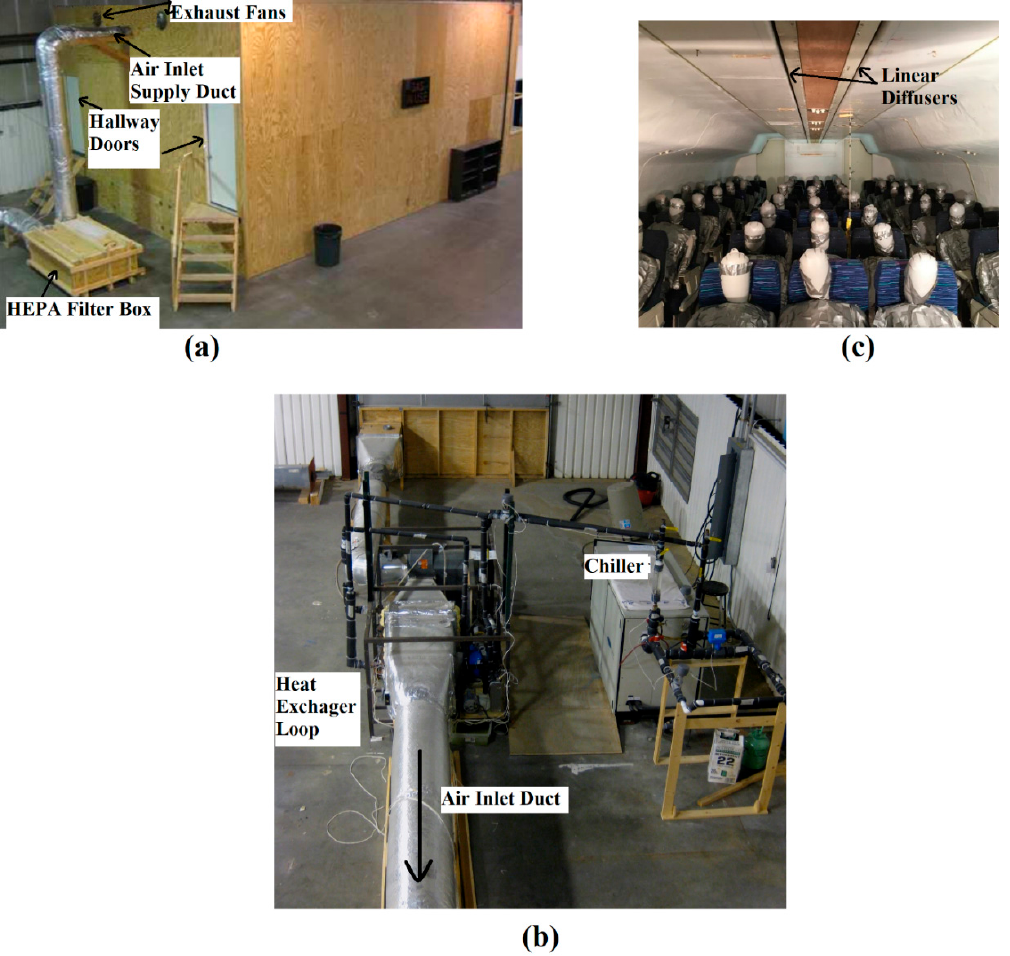
Figure 1. Cabin mockup ( a ) exterior; ( b ) heating and cooling loops; and ( c ) interior of the